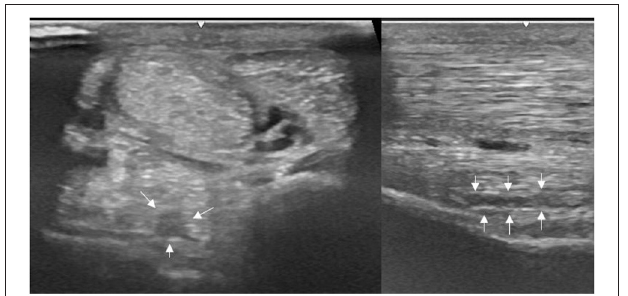
FIGURE 3 | A transverse image of a proximal suspensory ligament grade 3 lesion about 3cm distal to the head of the MTII and one longitudinal image of proximal metatarsal area. The hypoechogenic lesion extends transversely in the entire dorsal area of the ligament (small white arrows). Longitudinally, more than 50% of the fibre pattern is lost and the dorsal margin of the ligament has poor demarcation. In transverse images medial is to the left; in longitudinal image proximal is to the left.